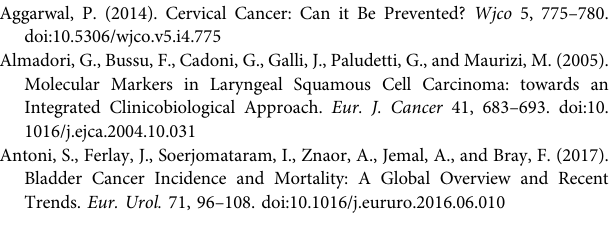
Frontiers in Cell and Developmental Biology |